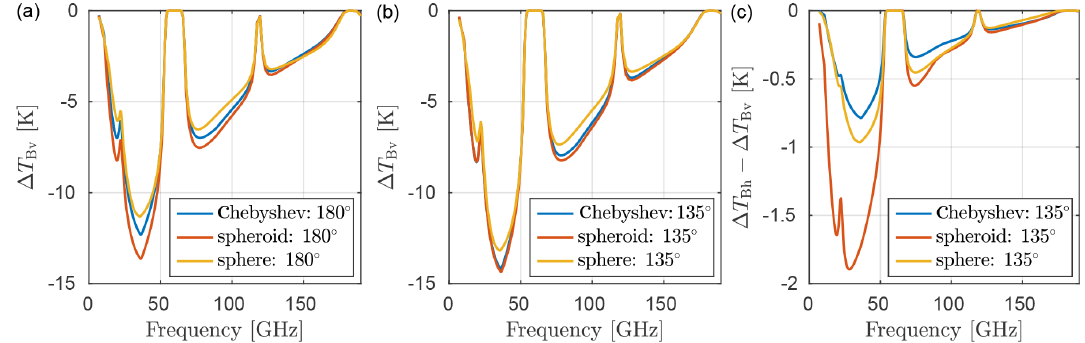
Figure 7. Passive forward simulations of rain using different combinations of line-of-sight angle and particle models. Panels (a) and ( b) show the differences (cid:49)T Bv in vertically polarized brightness temperatures between the cloud and rain cases compared to clear-sky case. Panel (a) assumes 180 ◦ and panel (b) 135 ◦ . Panel (c) shows the polarization difference T Bh − T Bv at 135 ◦